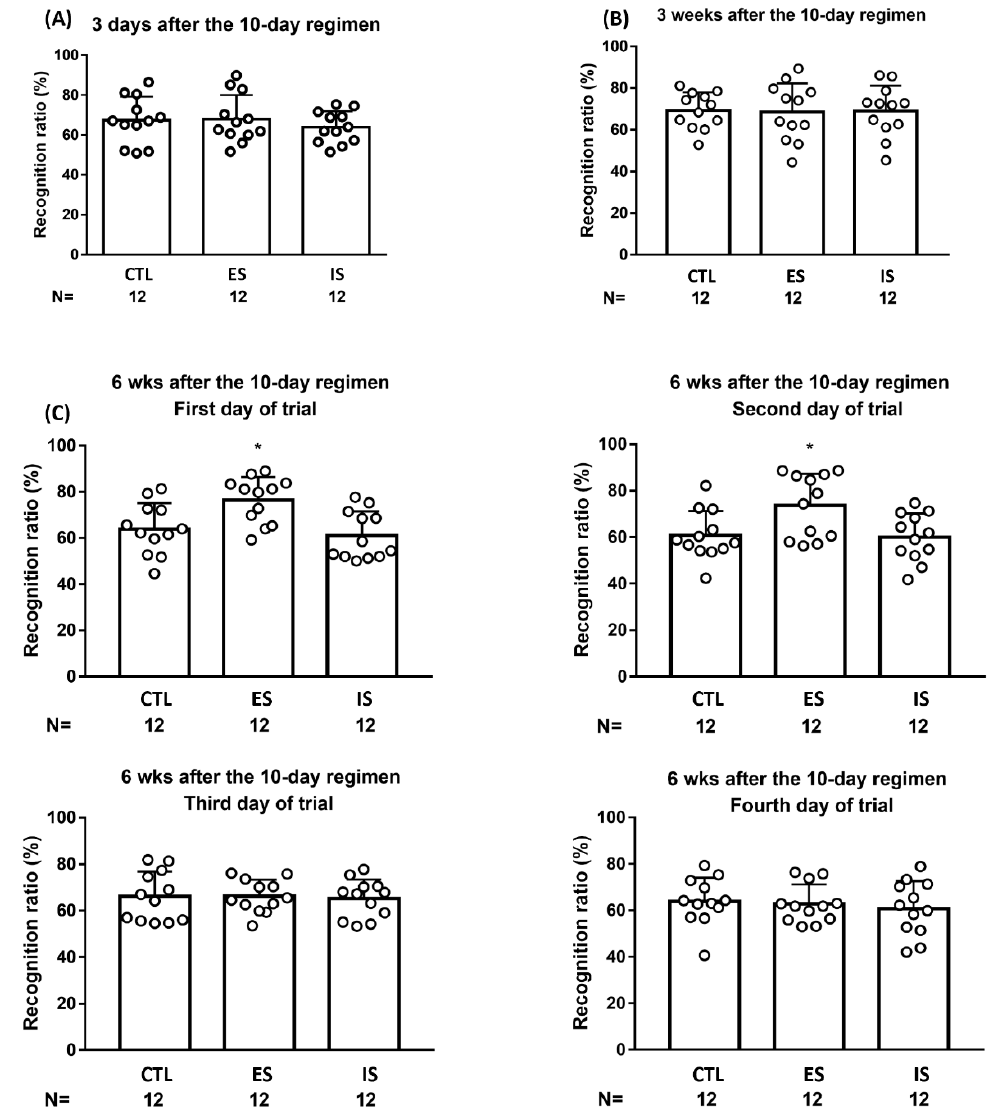
Figure 5. Mouse performances in object location working memory at 3 days, 3 weeks, and 6 weeks after the conclusion of the 10-day stressor regimen. ( A ) ES, IS, and control (CTL) mice performed indistinctly in their recognition ratios 3 days after the conclusion of the regimen. ( B ) ES, IS, and control mice performed comparable recognition ratios 3 weeks after the stressor regimen. ( C ) ES mice outperformed IS and control mice in recognition ratios in this object location task during the first and second, but not the third or fourth, days of the trial 6 weeks after the conclusion of the 10-day stressor regimen. * Significantly greater than IS and control groups. Data are plotted as mean ± SD.